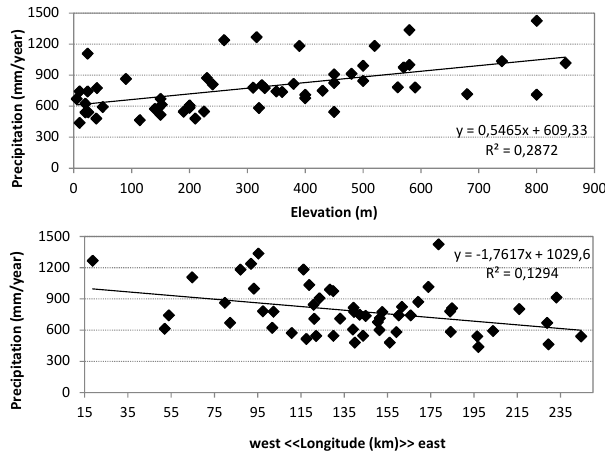
Fig. 2. (a) Elevation versus mean annual precipitation plot and (b) Longitude versus mean annual precipitation plot for Crete.